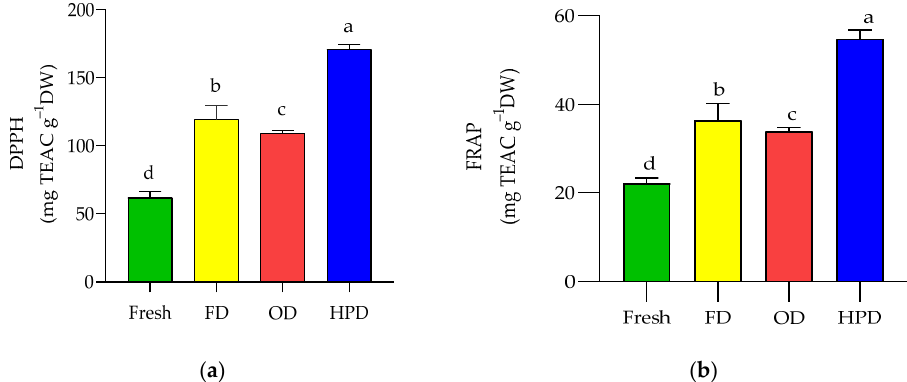
Figure 2. Antioxidant activity of fresh or dried leaves of U. dioica plants collected in the wild. Leaves were dried with different methods: freeze-drying (FD), oven-drying (OD) and heat pump drying (HPD). Antioxidant activity was determined with two different assays: 2,2-diphenyl-1-picrylhydrazyl hydrate (DPPH) ( a ) and ferric reducing antioxidant power (FRAP) ( b ). Means keyed with a different letter are significantly different for p = 0.05 following LSD test.